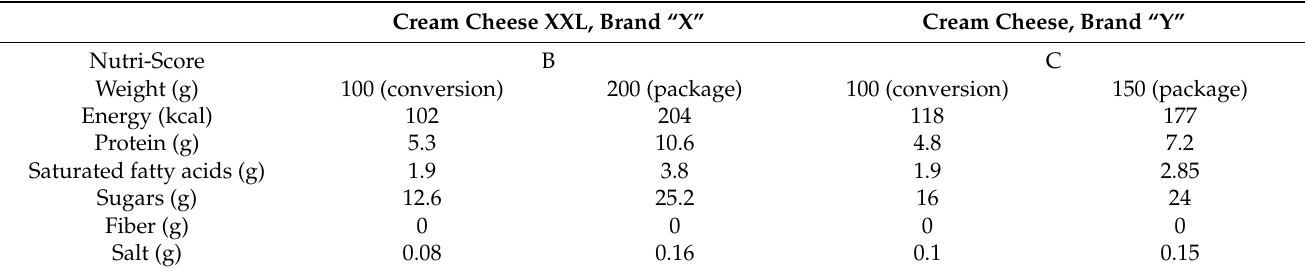
Table 1. Comparison of nutrient contents of commercially available cream cheeses by package